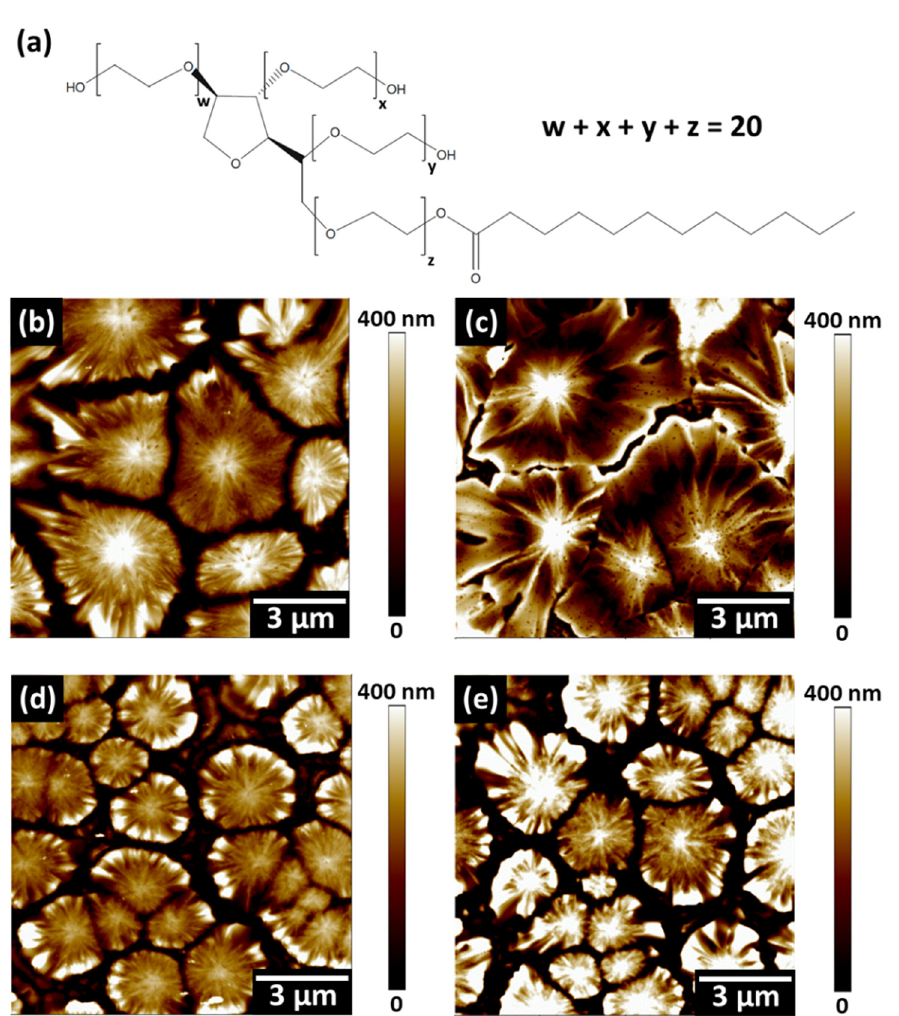
Figure 1. ( a ) Chemical structure of the surfactant Tween 20 and the AFM images of perovskite films with various Tween 20 concentrations, including ( b ) 0.0, ( c ) 1.0, ( d ) 2.0, and ( e ) 3.0 mM.